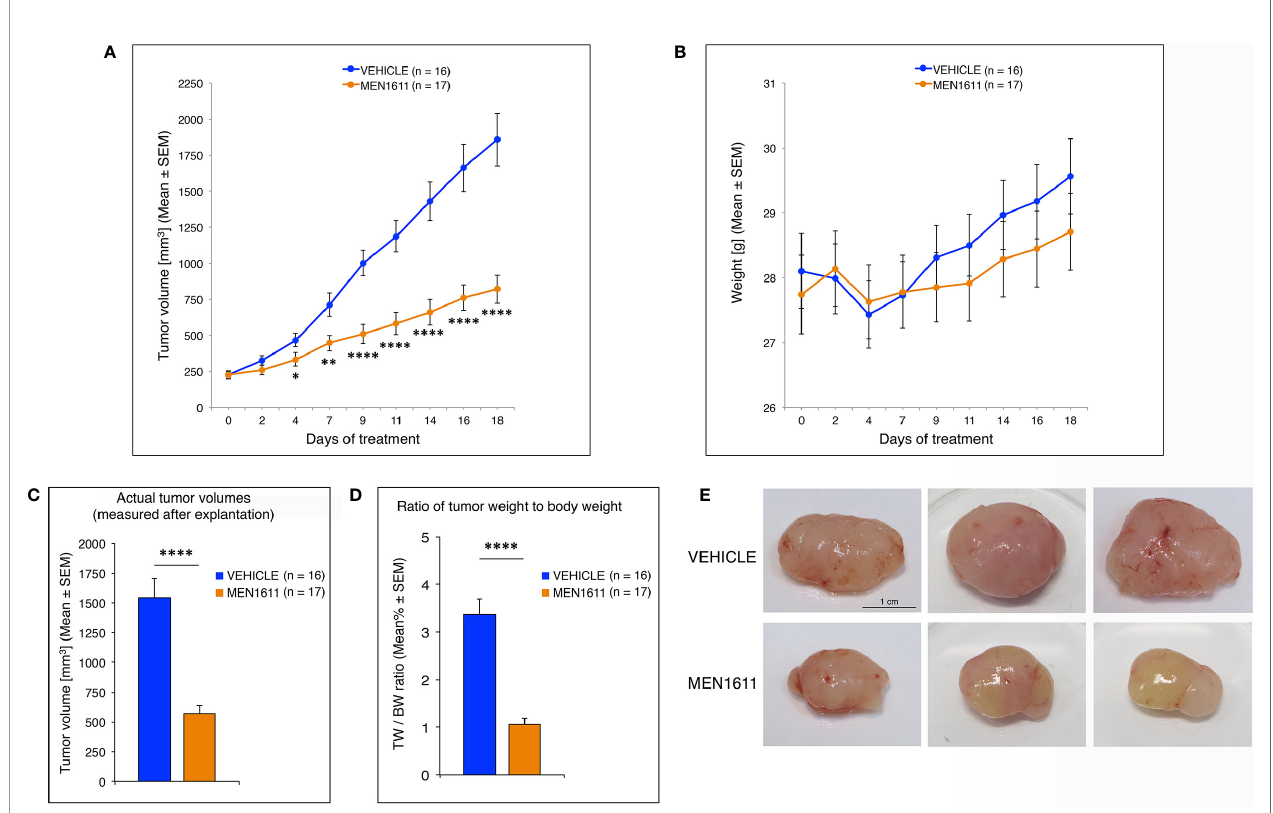
FIGURE 6 | Administration ofthe PI3K inhibitorMEN1611 signi fi cantly reduces tumor growth in the Ptch1 +/ − /Tis21 KO MBallograft. (A) Growth curves of nodules obtained bygrafting primary Ptch1 +/ − /Tis21 KO MBtumor cells subcutaneously into theright fl ank of nudemice. The mice were treated for 18 dayswith vehicle (blue) or MEN1611 (orange) at 6.5 mg/kg dose byoral gavage. The fi lled circles andthe error barsindicate theaverage± SEM of thetumor volumes measured at thedaysoftreatment indicated. Theexperiment was repeated3 times using5 – 6 mice in eachgroup( n = 16 for vehicle, n = 17 for MEN1611);there were nodifferences observedonanti-tumor effectiveness of MEN1611 inthese three experiments. * p < 0.05, ** p < 0.01, **** p < 0.0001, Student ’ s t -test. (B) Bodyweight ofmice fromMBallograft experiments in (A) . The body weight of each mouse under study was recorded on the indicatedtreatment days; data are expressedas mean ± SEM.The treatment with MEN1611 does not cause a signi fi cant reduction inbodyweight betweencontrol andtreatment group,indicatingthetolerability of MEN1611. (C) The bar graphshows the mean ± SEM of the nodule volumes measured at the end of 18 day-treatment after explantation.**** p < 0.0001, Student ’ s t -test; mice analyzed: n = 16 for vehicle, n = 17 for MEN1611. (D) The ratioof tumorweight (TW) to body weight (BW) was calculated for each treatment group (Vehicle: 16 mice; MEN1611: 17 mice) as mean%± SEM.**** p < 0.0001, Student ’ s t -test. (E) Representative images of MEN1611- and vehicle-treatednodules are shown. Scalebar:1